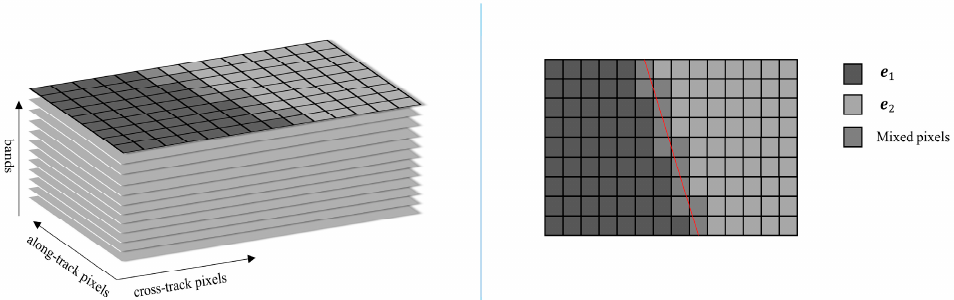
Figure 4. The selected subregion with a crossed edge represented by the red